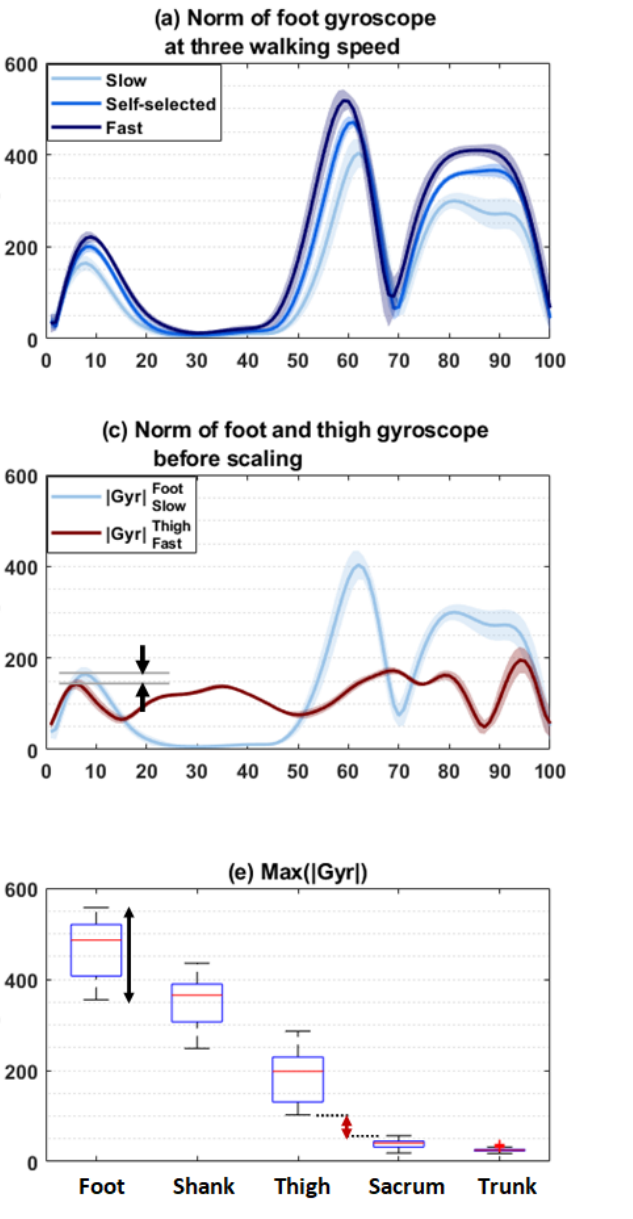
Figure 5. Effect of scaling by stride time. The amplitude of the foot gyroscope signal | Gyr Foot | at different gait speeds ( a ) before and ( b ) after scaling shows more similarity. Comparison of the amplitude of the | Gyr Foot | with | Gyr Thigh | at different gait speeds ( c ) before and ( d ) after scaling showing more separation. Features corresponding to the maximum of | Gyr | at different locations (foot, leg, thigh, sacrum, trunk) ( e ) before and ( f ) after scaling, showing less variability at the same location (black arrow) and more separation between locations (red arrow).